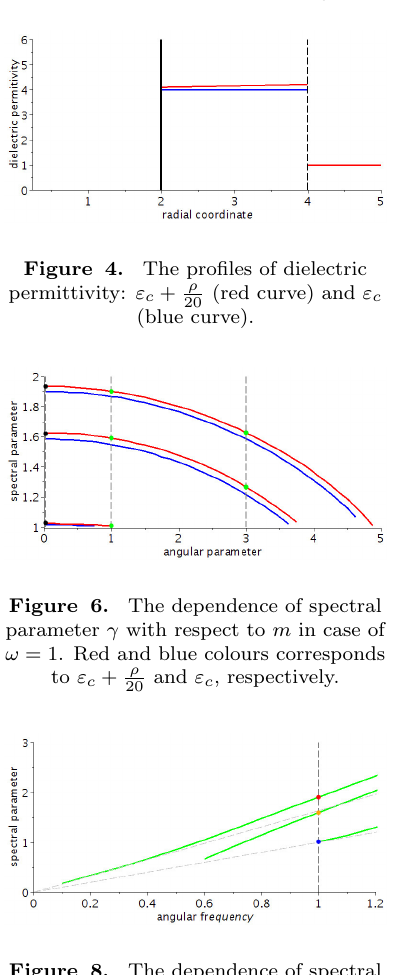
Figure 8. The dependence of spectral parameter γ with respect to frequency ω (dispersion curves) in case of m = 1. The permittivity is specified by ε c + ρ